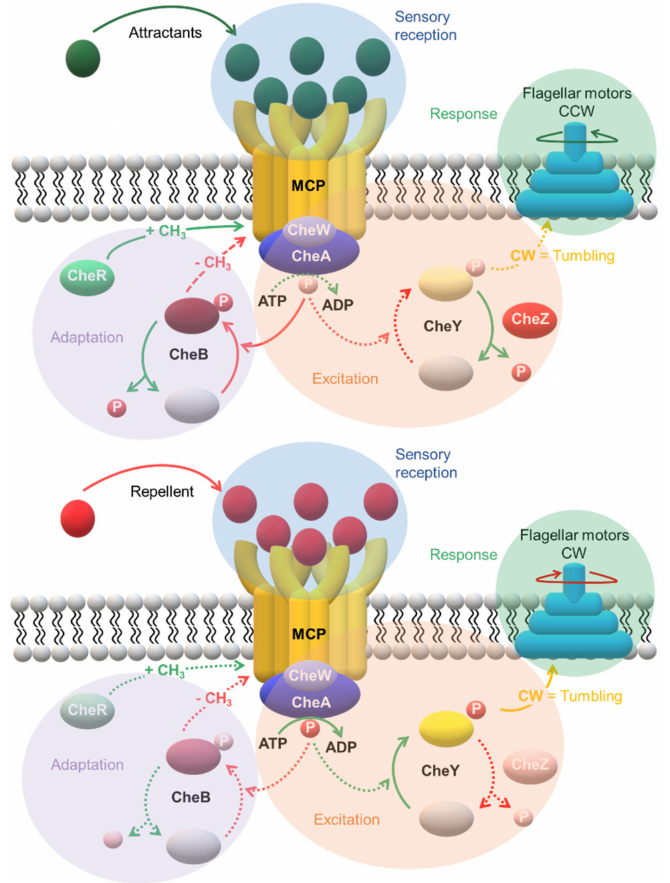
Figure 10. Mechanism of chemotaxis in E. coli . The chemoreceptors function as trimers of dimers. The rotation of the flagellar motor is regulated by the ratio of the phosphorylated form of CheY (CheY~P) versus its dephosphorylated form (CheY). Steady dephosphorylation of CheY~P by the phosphatase CheZ maintains a constant ratio of CheY~P/CheY and a basal level of alternating counterclockwise (CCW, causing cells to swim more straight runs—moving upwards the attractant gradient) and clockwise (CW, causing cells to tumble) rotation. This equilibrium is affected either by attractants or repellents. In the first case, the phosphorylation of CheA is blocked and the high levels of CheY favor the CCW rotation (see dashed arrows in the upper panel). On the other hand, repellents decrease the CheZ activity and increase both the levels of CheA~P and CheY~P. As a consequence, CW rotation is favored. Both processes are called excitation. A methylation feedback loop on the MCP re-establishes the basal CheY~P/CheY ratio